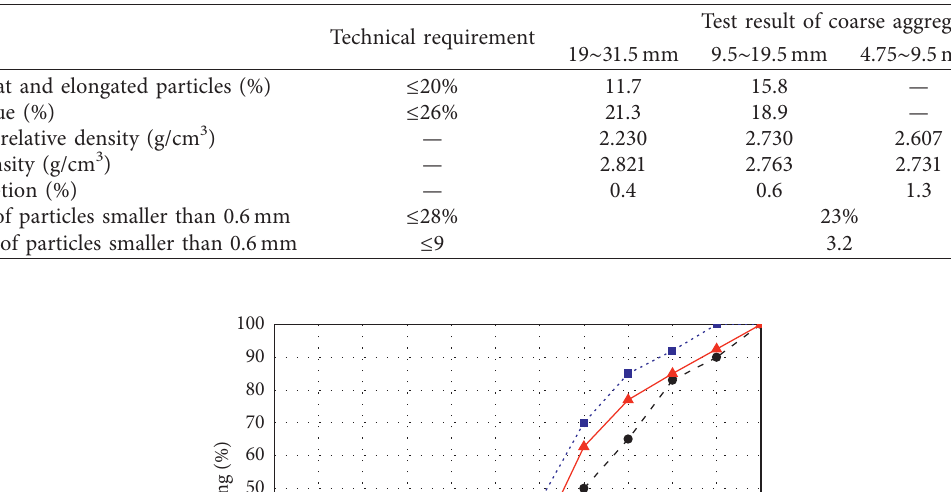
Table 2: Properties of limestone aggregate.